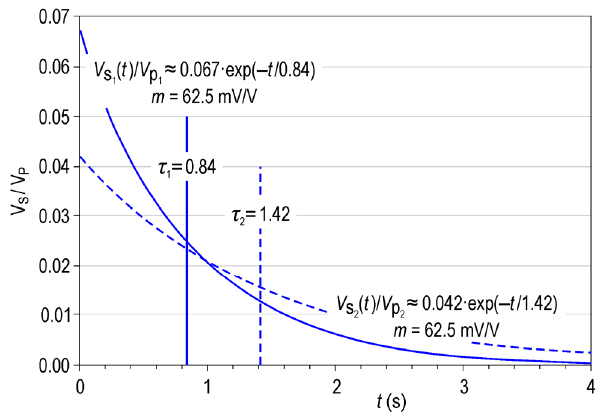
Figure 1. Example of two decay curves with the same chargeability but different polarisabilities and decay times.